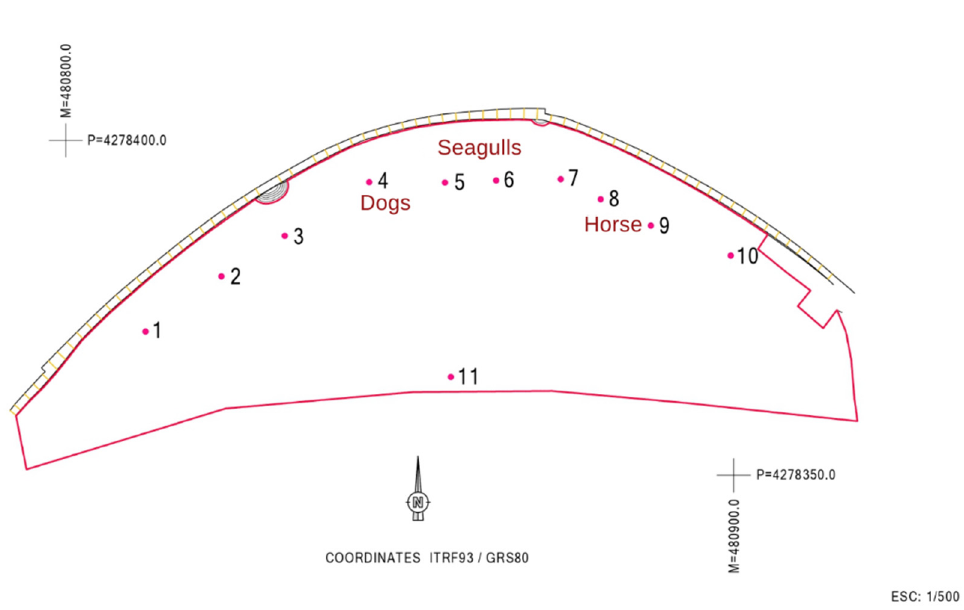
Figure 3. Assignment of the respective contamination sources to each of the sampled sites.